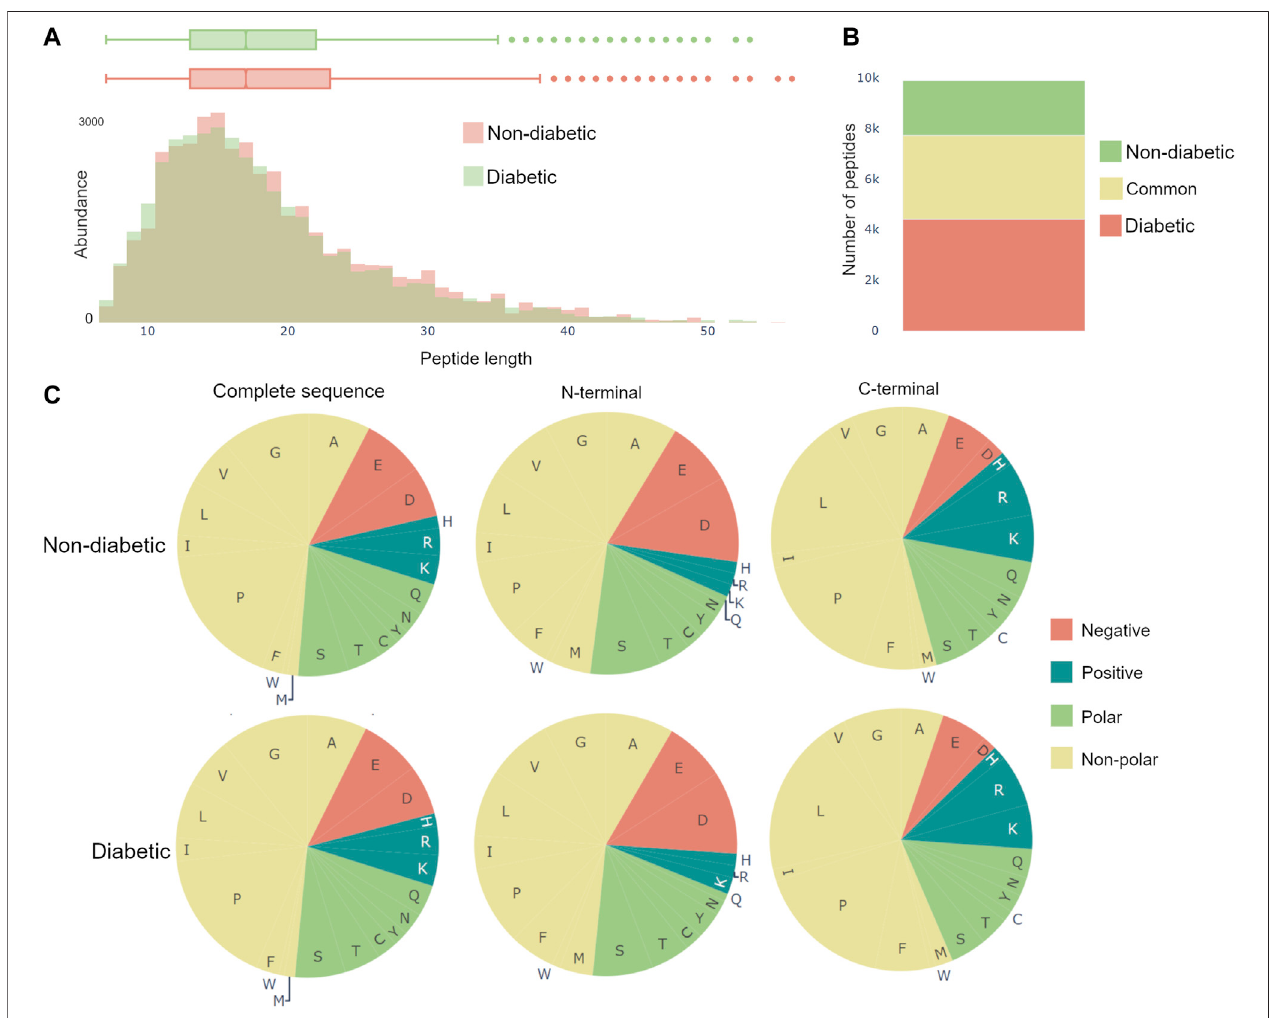
FIGURE 4 | General characteristics of the complete peptidomes. (A) The length distribution of peptides, weighted by the abundance metric. (B) Venn bars, showing the overlap of the peptidomes. (C) Amino acid pro fi le, showing the amino acid prevalence for the complete sequence, as well as the fi rst and last amino acid.